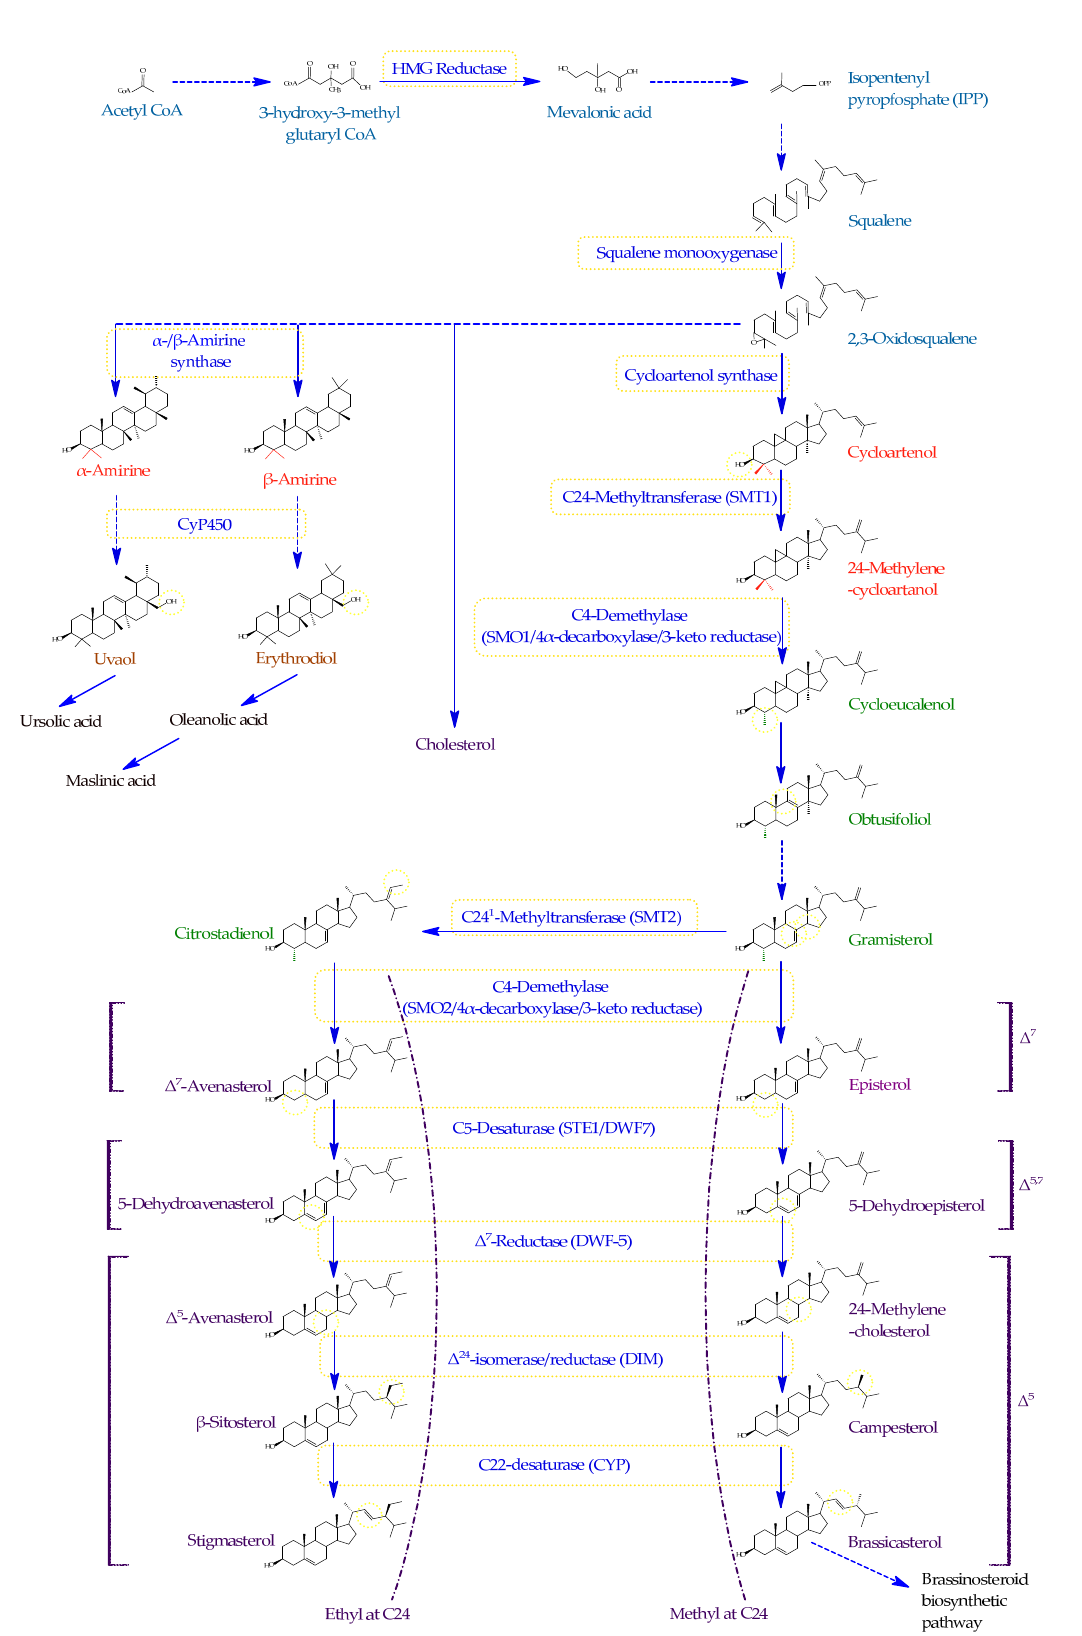
Figure 2. Schematic diagram of the biosynthetic pathway of plant sterols in higher plants [8,15,27] with a special emphasis on sterols found in olive oil, showing the main structures of 4-desmethylsterols (violet), as well as 4-methyl (green) and 4,4 ′ -dimethylsterols (red) as their biogenetic precursors. Parallel pathways of the synthesis of cholesterol and triterpene diols erythrodiol and uvaol are also shown. Dashed arrows represent several enzymatic steps not shown.